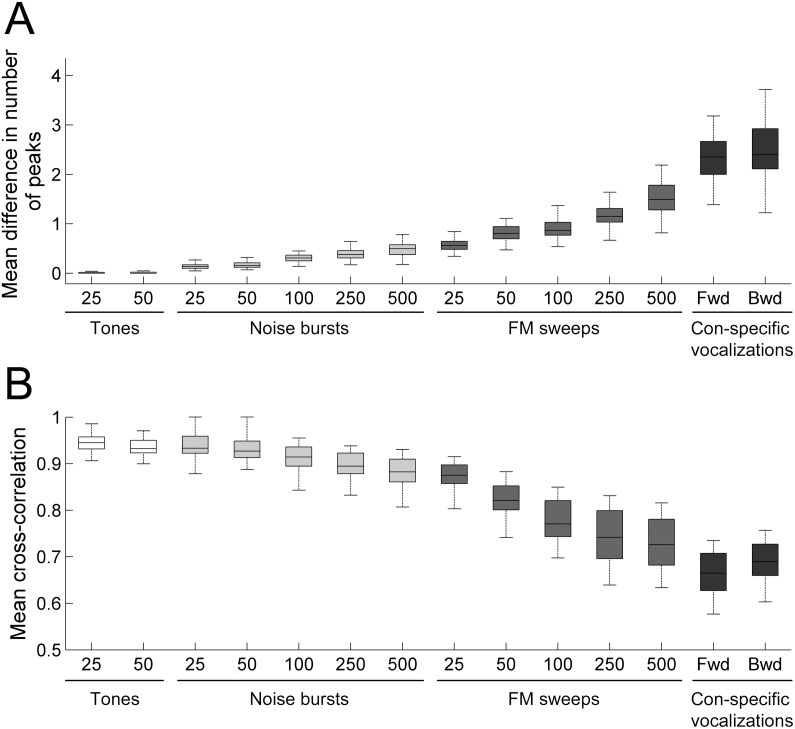
Distribution of neuronal response similarity levels within primary auditory cortex columns.(A) Distribution of PSTH peak response incidence during pure tone, white noise, FM sweep, and con-specific vocalization signals. (B) Distribution of response profile similarity (cross-correlation value at time-lag zero) during pure tone, white noise, FM sweep, and con-specific vocalization signals. Note the increase in response dissimilarities as a function of acoustic signal duration. Horizontal lines in boxplots illustrate lower quartile, median, and upper quartile values. Whisker length shows limits of data distribution.